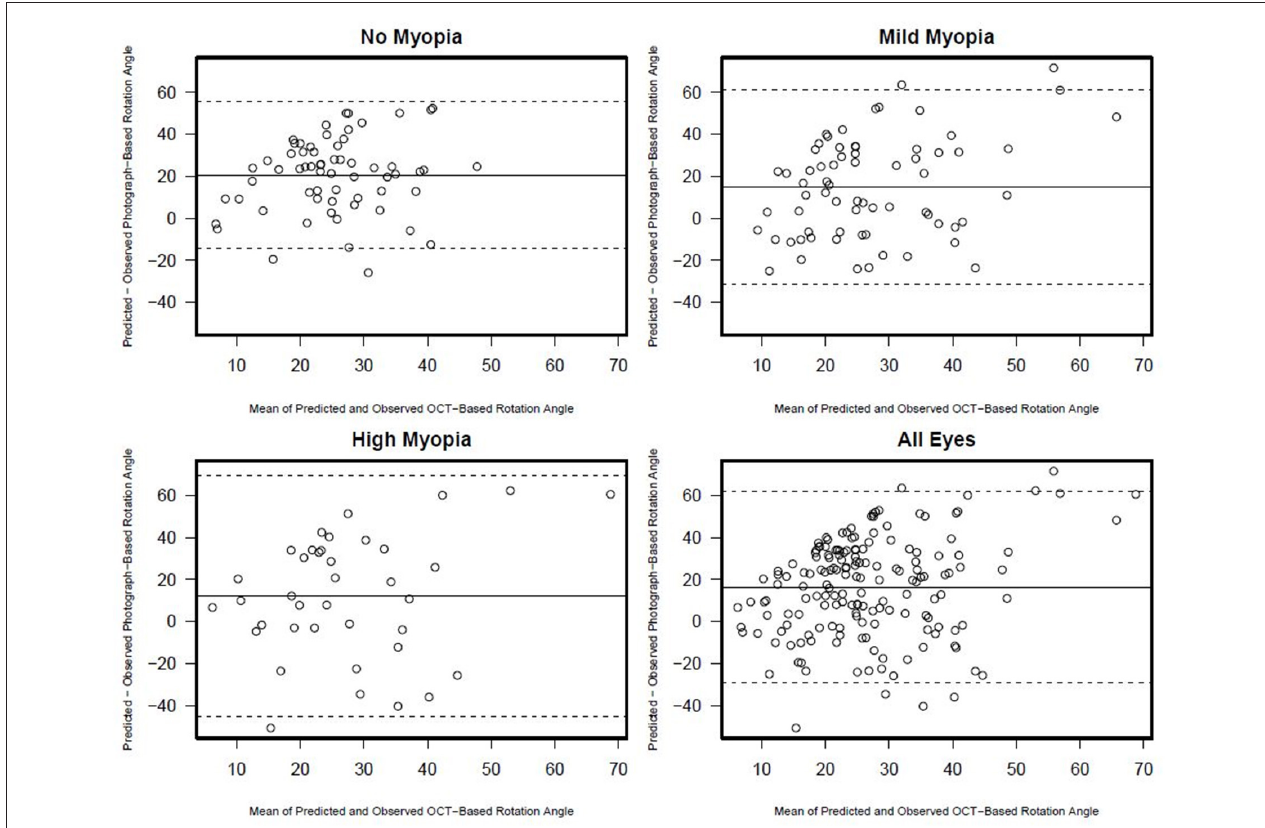
FIGURE 6 | Rotation angle Bland-Altman plots documenting the agreement between photograph and OCT based rotation angle by myopia